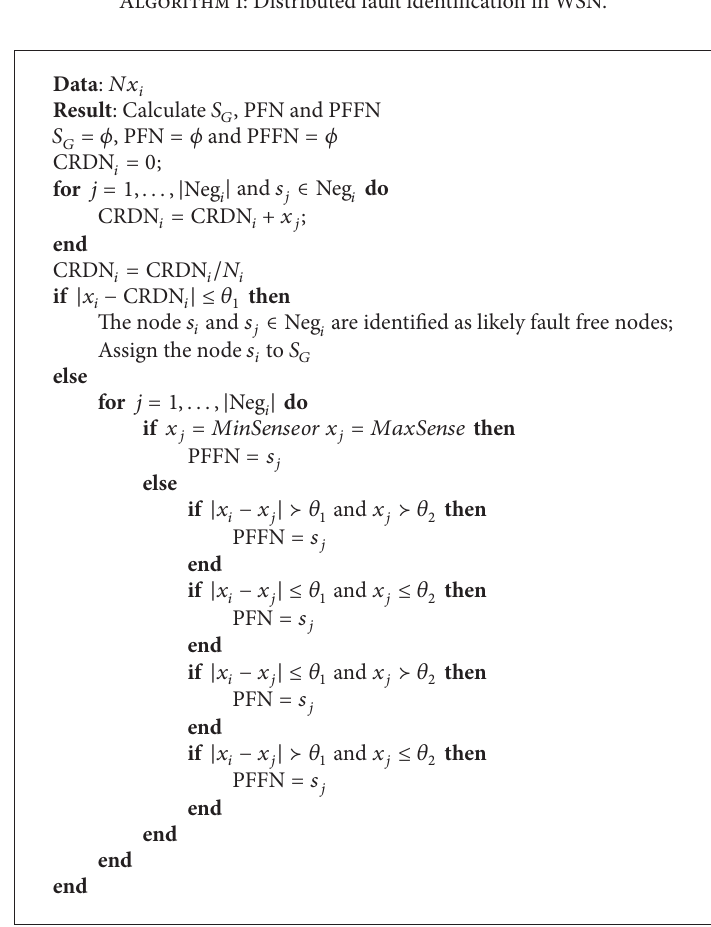
Algorithm 2: Random fault identification